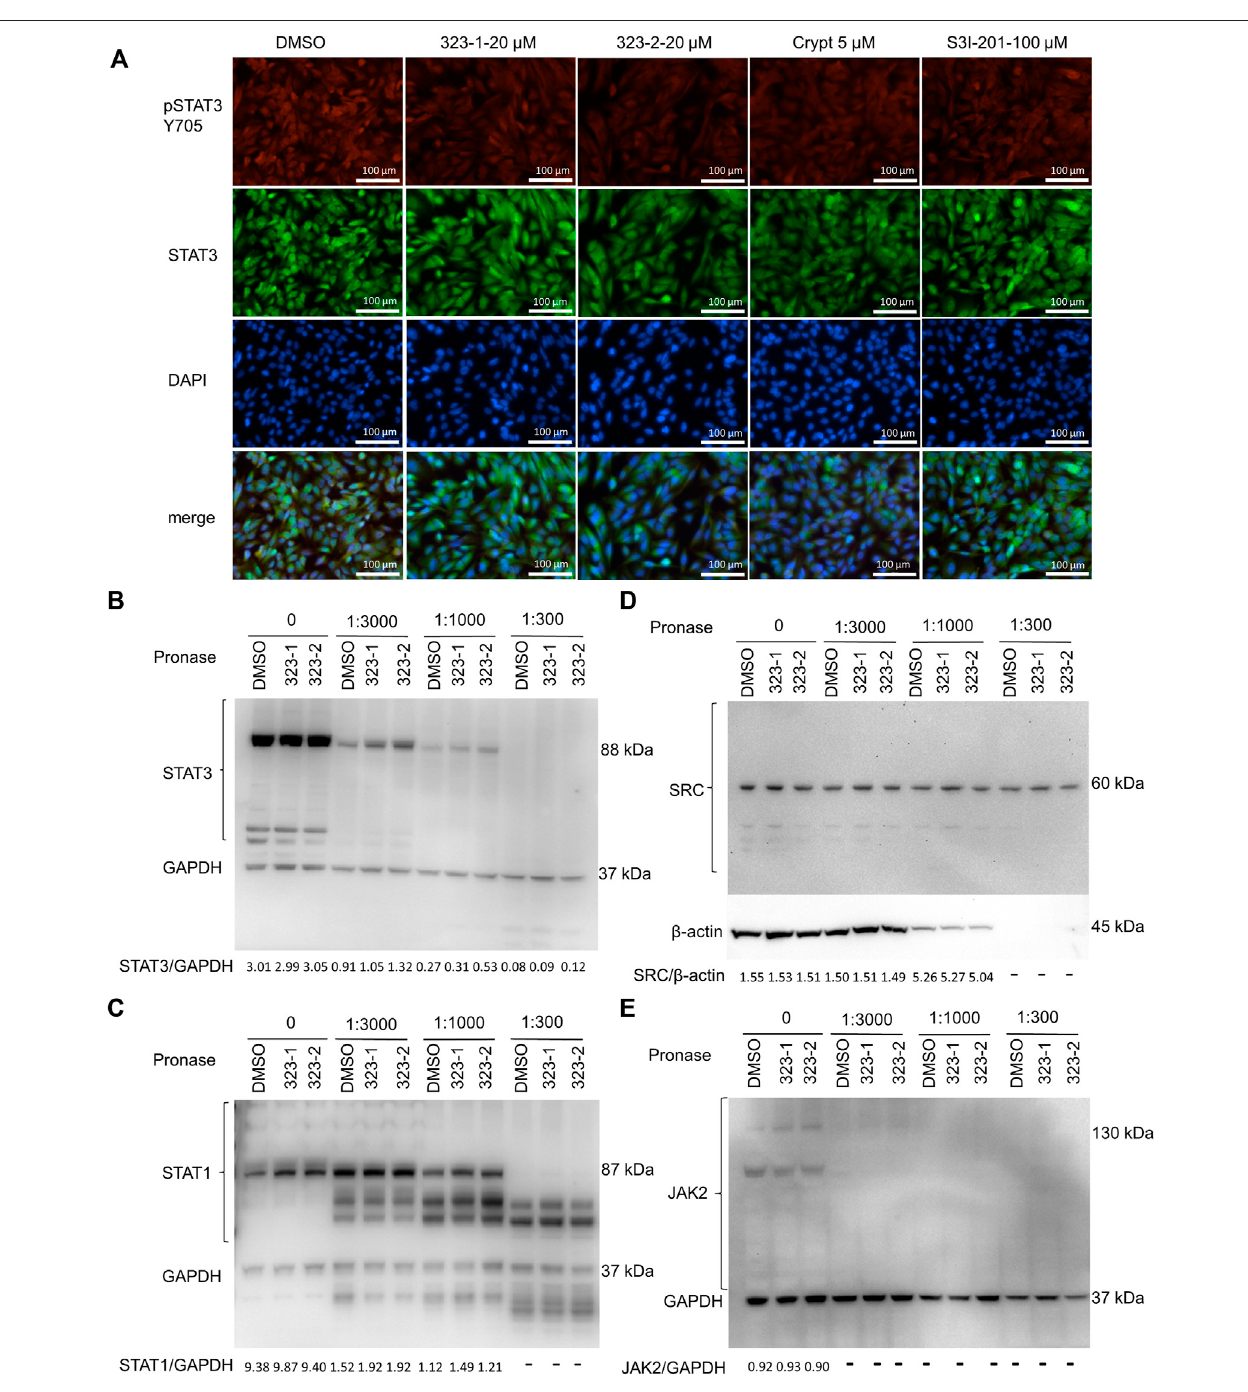
FIGURE2| Compounds323 – 1and323 – 2targetpSTAT3overpSTAT1. (A) Indirectimmuno fl uorescencemicroscopyofEPT3M1-STAT3cells.Cellsweretreated withDMSO, 20 µM 323 – 1, 20 µM 323 – 2,5 µMcryptotanshinone (Crypt), or100 µM S3I-201 for24 h. They wereincubated withthe primary